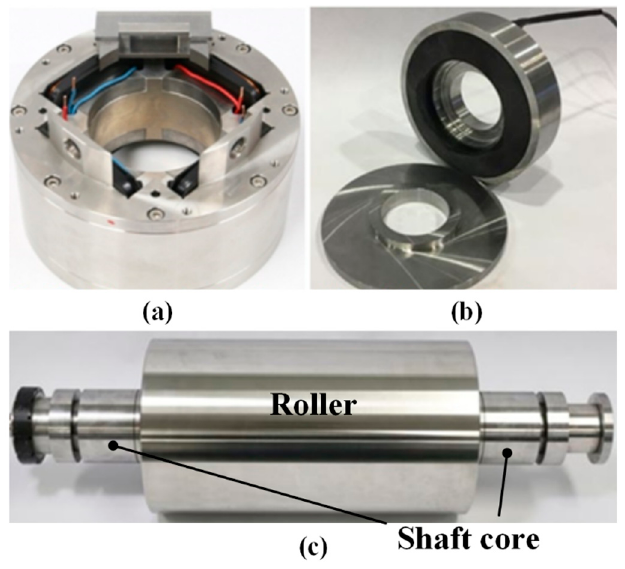
Figure 5. Fabricated roller and magnetic bearings for automatic alignment function: ( a ) radial magnetic bearing; ( b ) thrust magnetic bearing; and ( c ) precision roller.